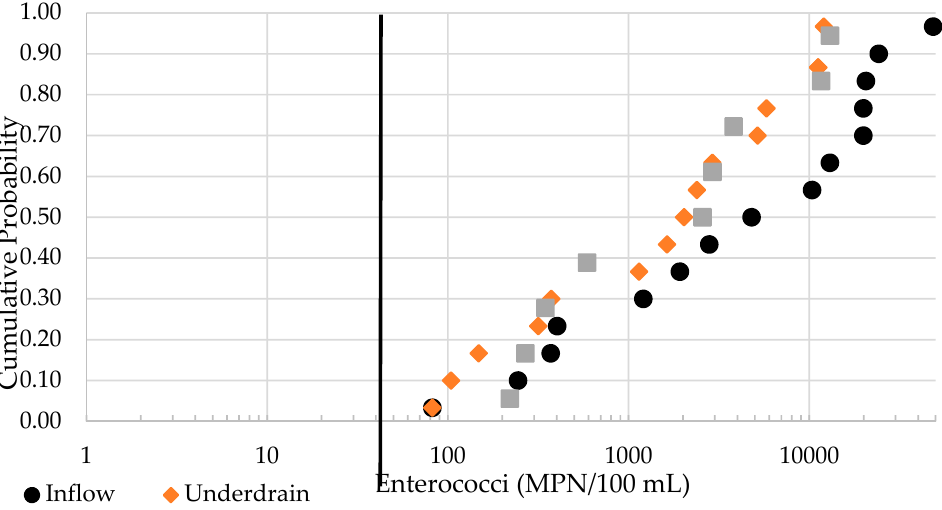
Figure 6. Enterococci probability plot with water quality standard of 35 MPN/100 mL.